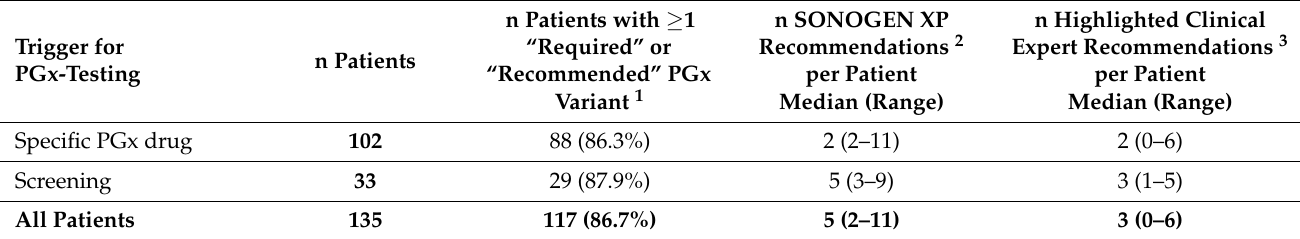
Figure 2. Frequency distribution of pharmacogenetic phenotypes in the study population. Phenotypes for the individual genes were assigned according to the latest available standardized nomenclature (see methods Section 2.4, including references for each genotype/phenotype). Table 4. Detected phenotype variants and related alerts relevant for potential future